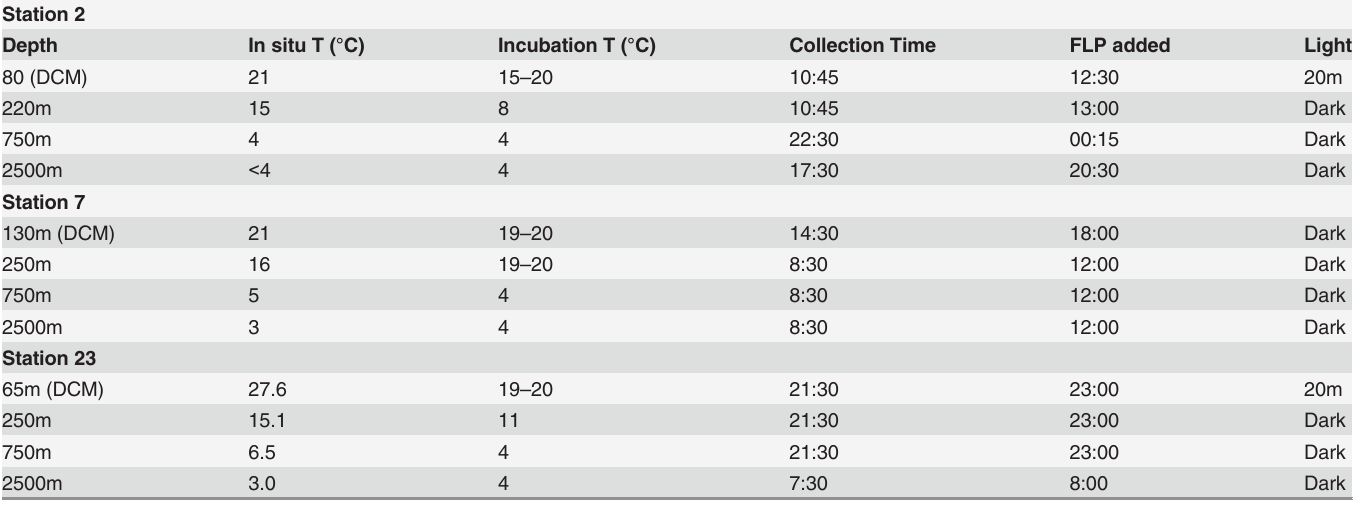
Table 2. Temperatures, light levels and sampling times for grazing experiments at stations 2, 7 and